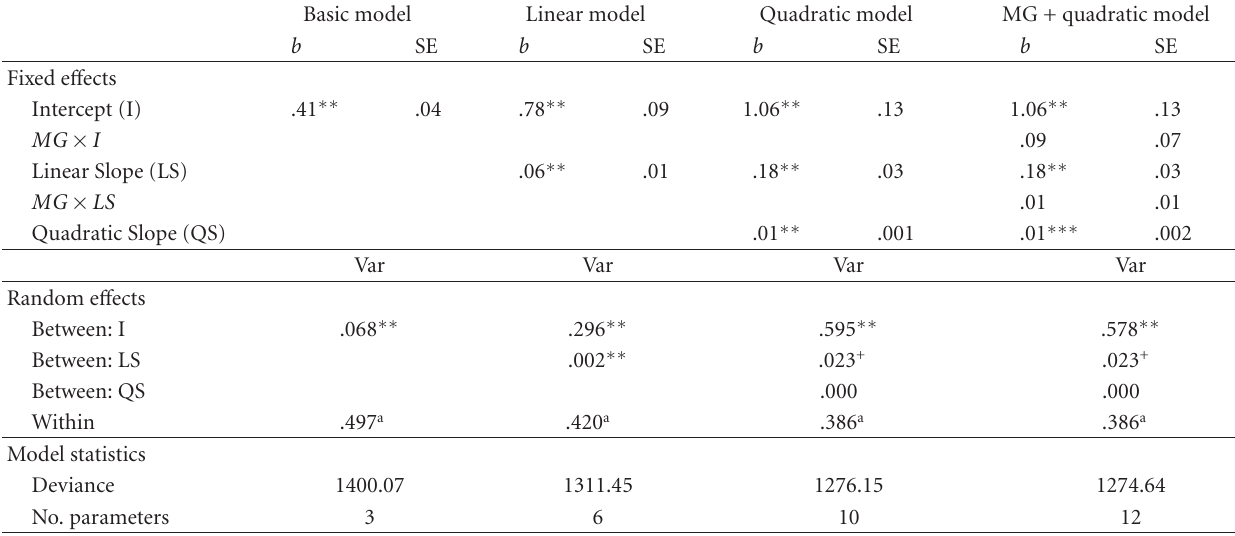
Table 4: Analysis of change in planning strategies prior to test completion.